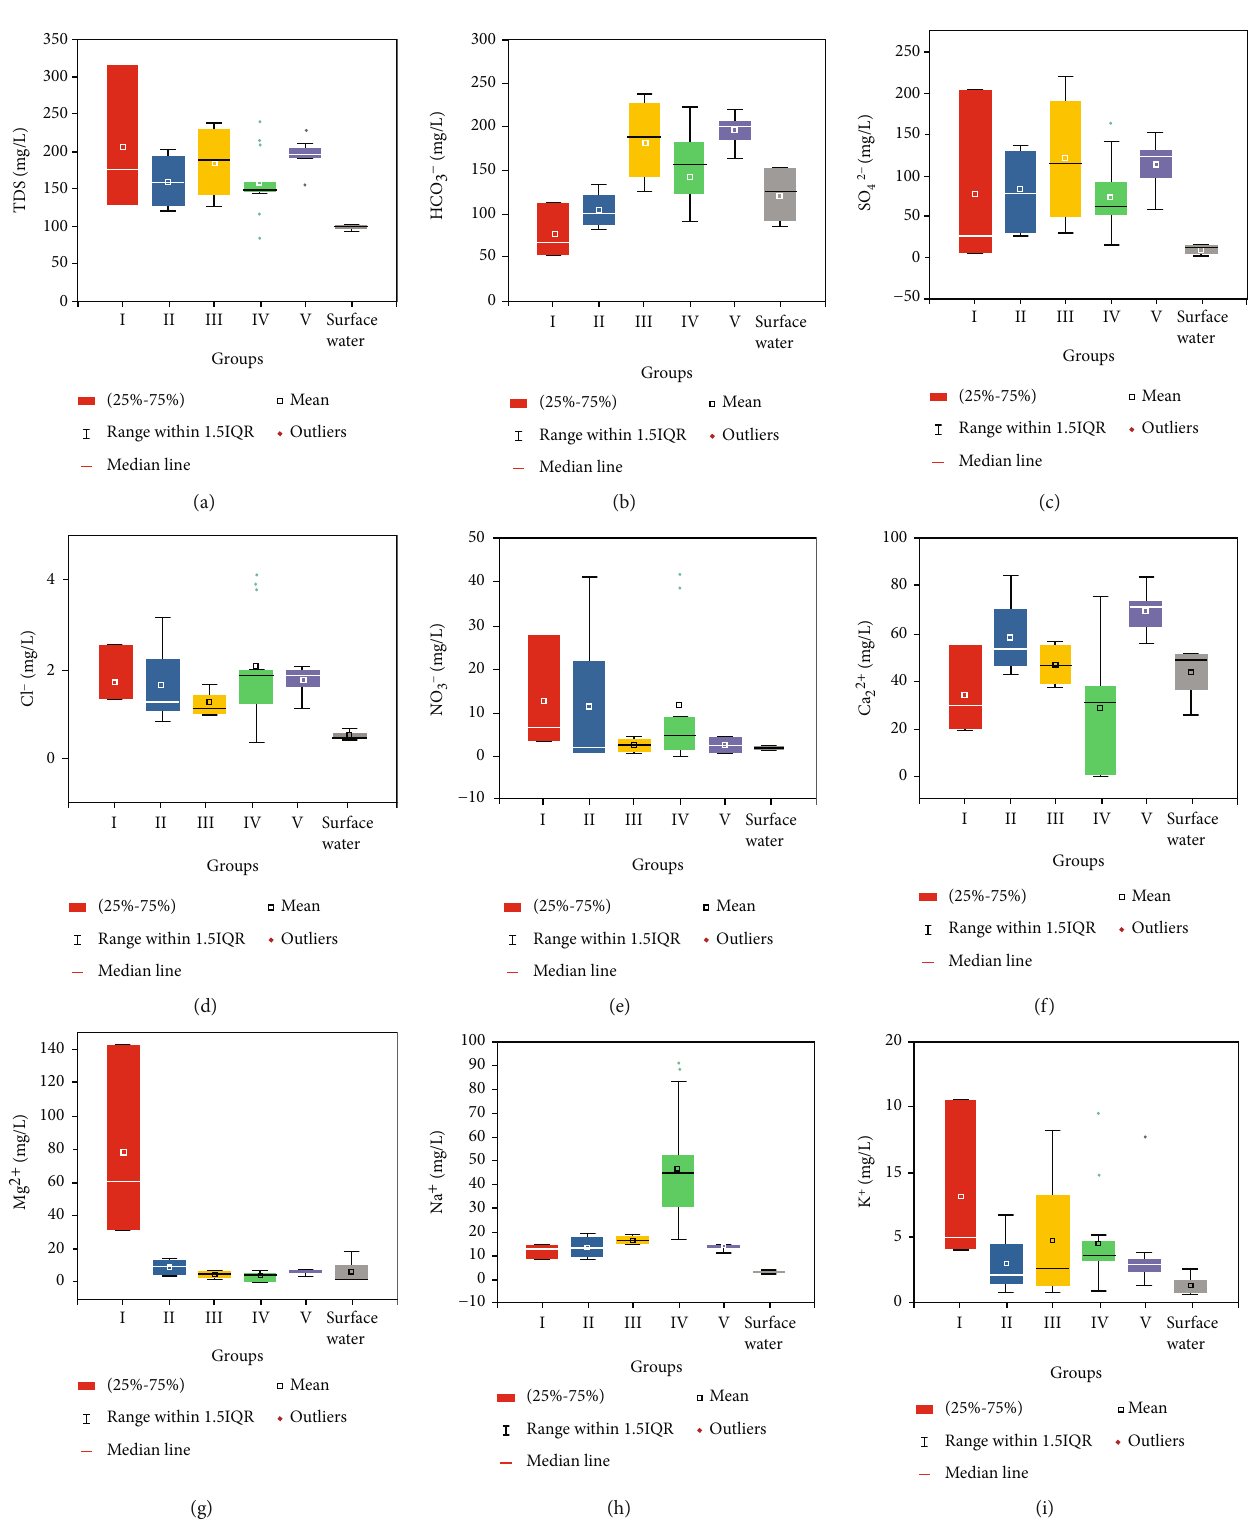
Figure 3: Box diagram of main ion concentration in the study